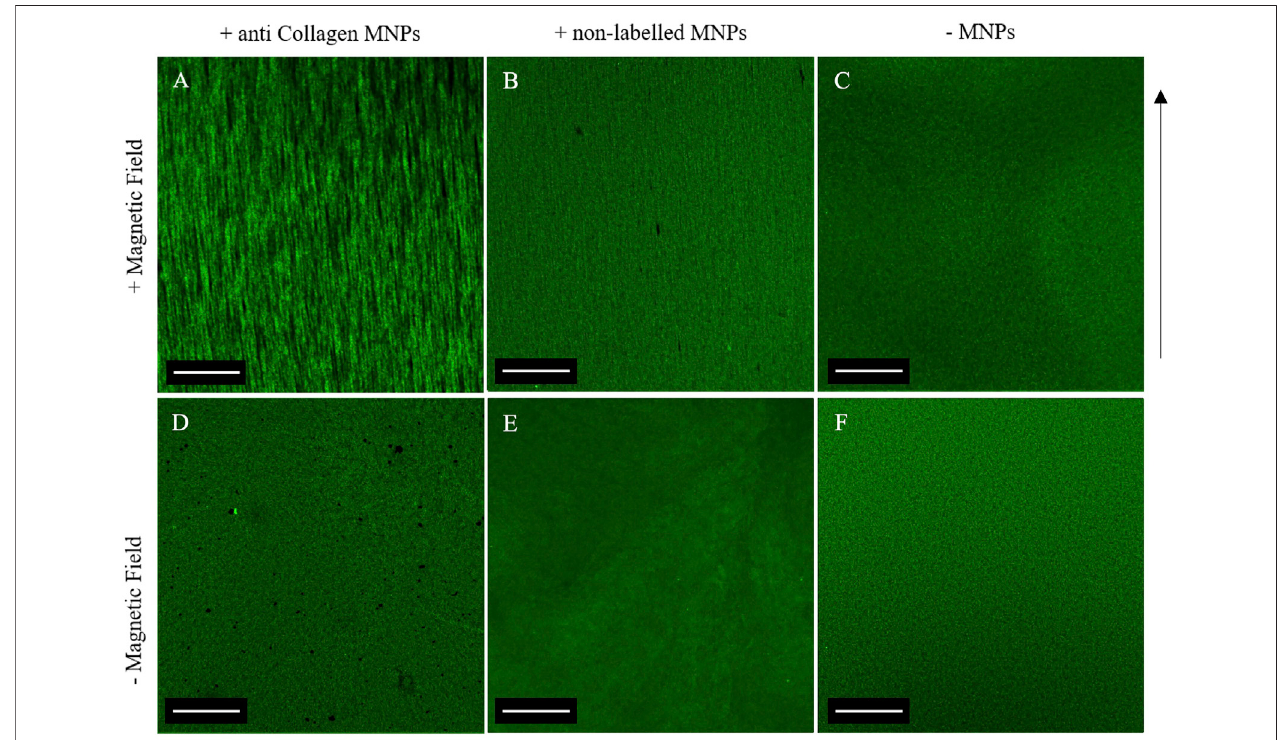
FIGURE 3 | Confocal microscopy of 0.5 μ g/ μ l anti-collagen MNP-laden fl uorescent gels (A,D) , 0.5 μ g/ μ l non-labeled MNP-laden fl uorescent gels (B,E) , and non- magnetic fl uorescentgels (C,F) .Toppanel:gelspost-application ofthemagnetic fi eld.Bottompanel:gelswithnomagnetic fi eldapplication.Aclearstriatedmacroscale organization is only evident when a magnetic fi eld applied to anti-collagen MNPs (A) . In all other gels, a disorganized matrix is shown, and the anisotropic topography is absent. Scale bar = 1 mm, magni fi cation = ×4, green = collagen I, arrow = direction of magnetic fi eld lines, and n = 3.